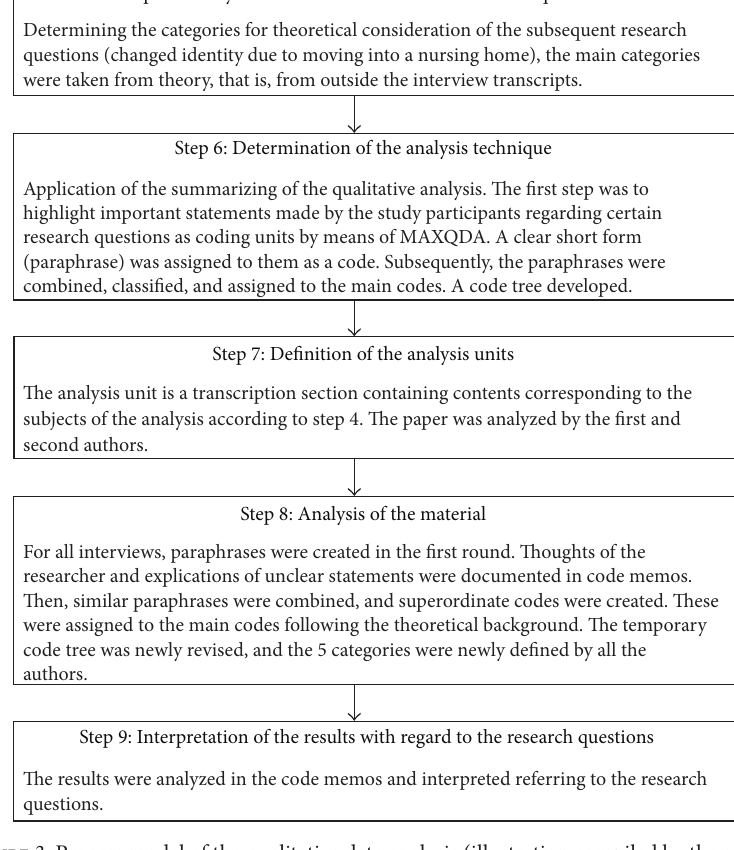
Figure 3: Process model of the qualitative data analysis (illustration compiled by the